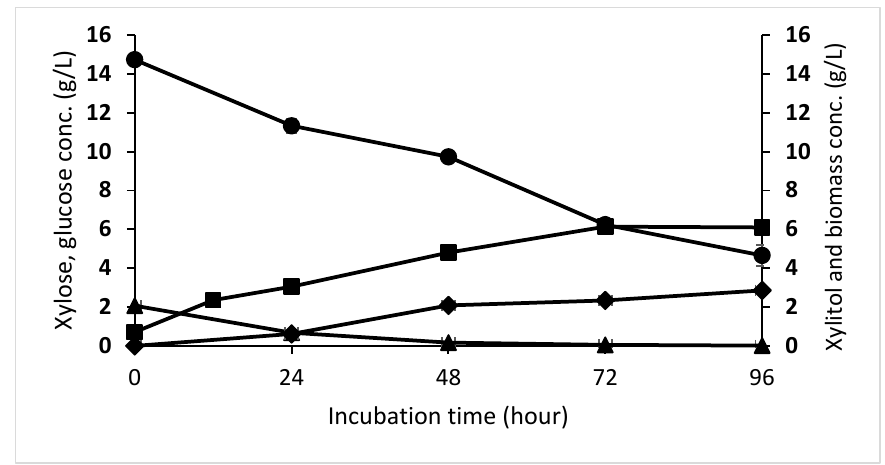
Figure 2. Xylitol fermentation profile. Xylose (solid circles), glucose (solid triangles), D. hansenii cell growth (solid squares), and xylitol (solid diamond). The data shown are the average of three replicate studies, and the error bars show the standard deviations.